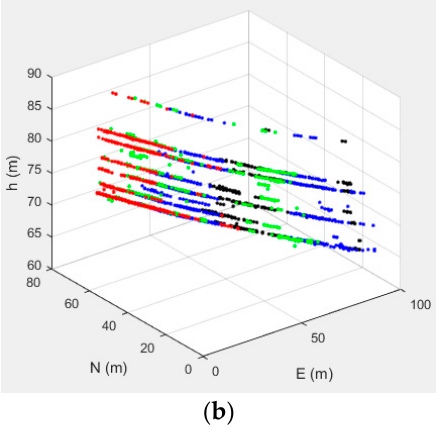
Figure 10. Generated power line points for the less dense interval case with threshold 4 (red, green, blue, and black for Strips 1, 2, 3, and 4, respectively).